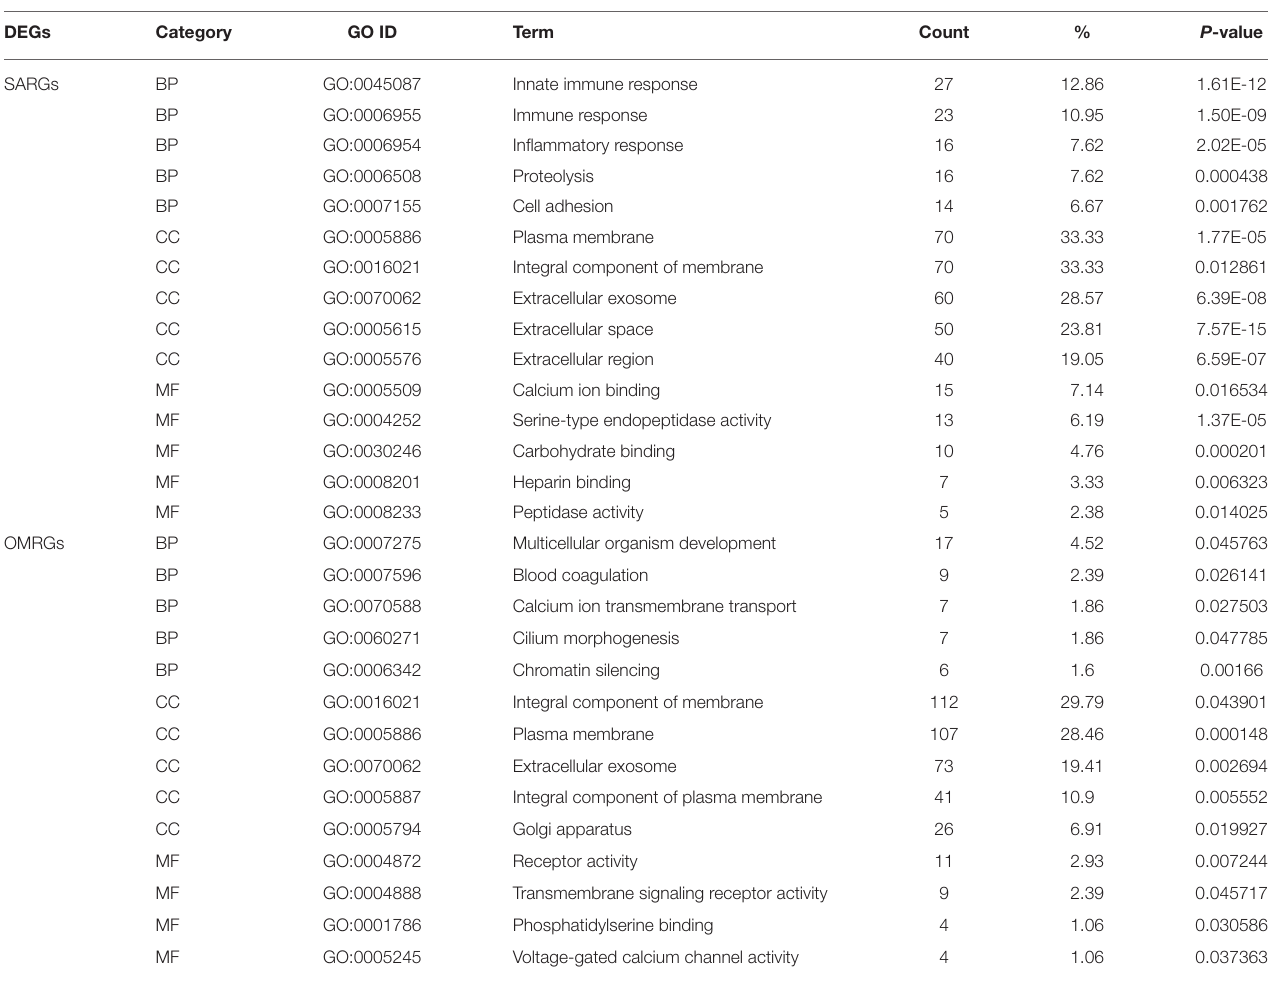
TABLE 1 | Gene ontology analysis of the SARGs and OMRGs (the top 5 GO